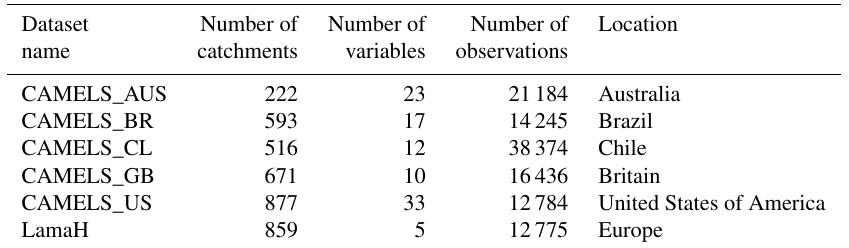
Table 2. Name and attributes of open-source datasets included in AI4Water. Dataset Number of Number of Number of variables